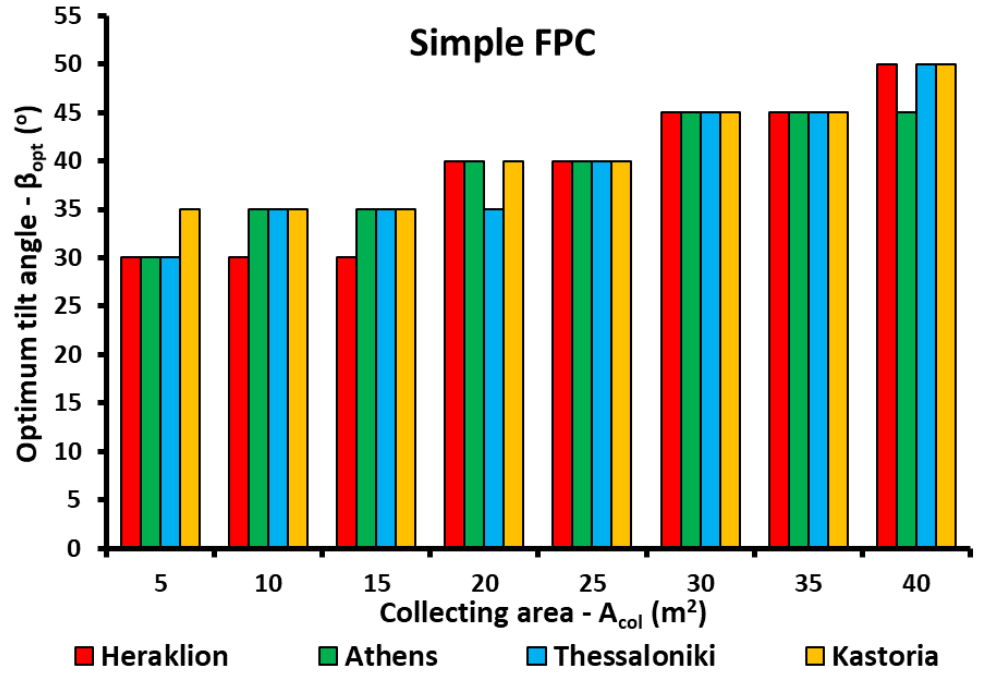
Figure 13. Optimum tilt angles for maximizing the solar coverage with simple FPC for the exam- ined locations.